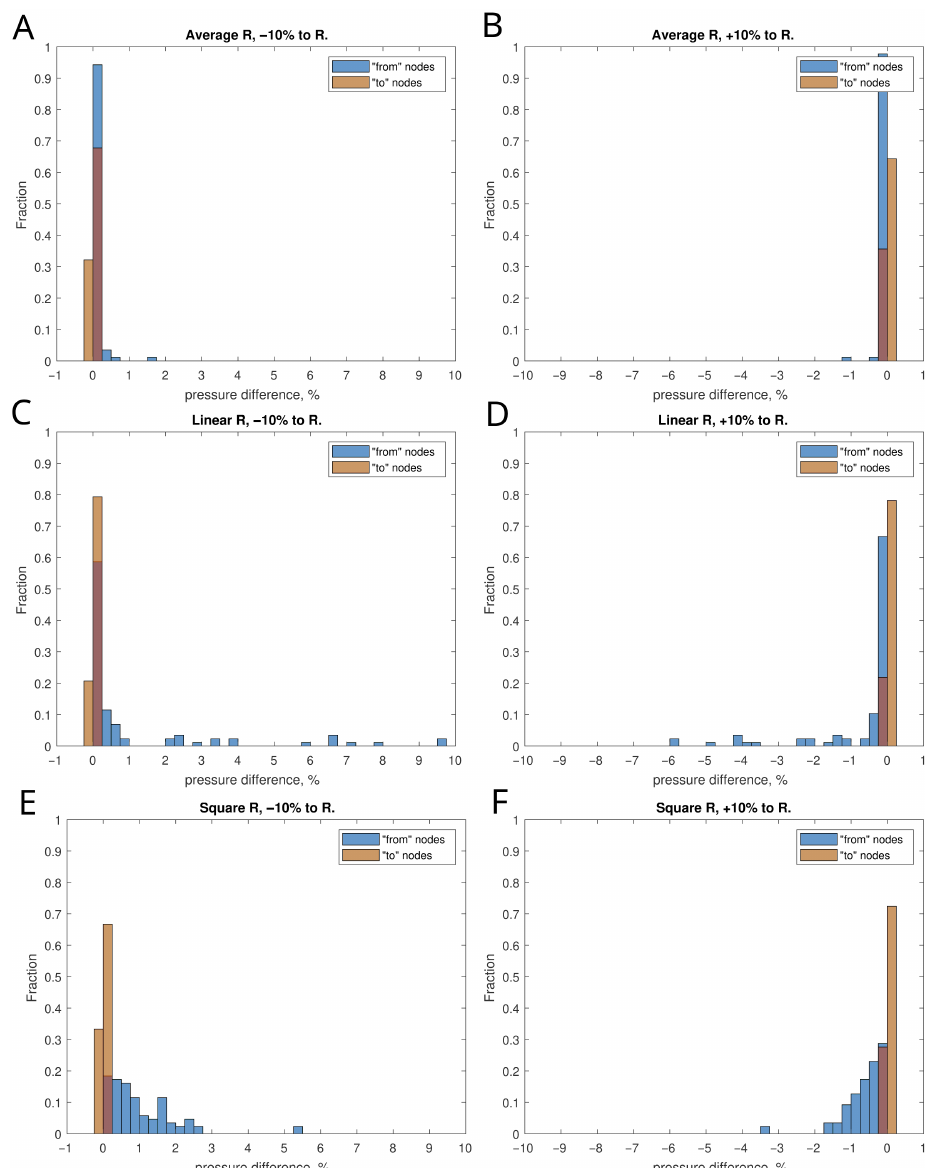
Figure 5. The distributions of the changes of pressures in the lymphatic vessels of the LS (vertices of the graph) after variation of the length diameters ( ± 10%) for Scenario 1 ( A,B ), Scenario 2 ( C,D ), and Scenario 3 ( E,F